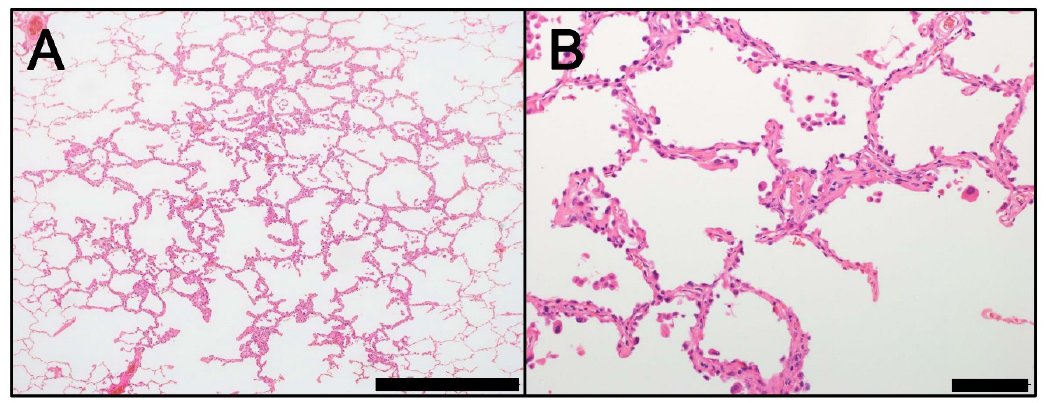
Figure 1. Morphology of AAH (hematoxylin and eosin staining). ( A ) Low magnification (Scale bar = 1000 µm). ( B ) High magnification (Scale bar = 100 µm). AAH, atypical adenomatous hyperplasia.